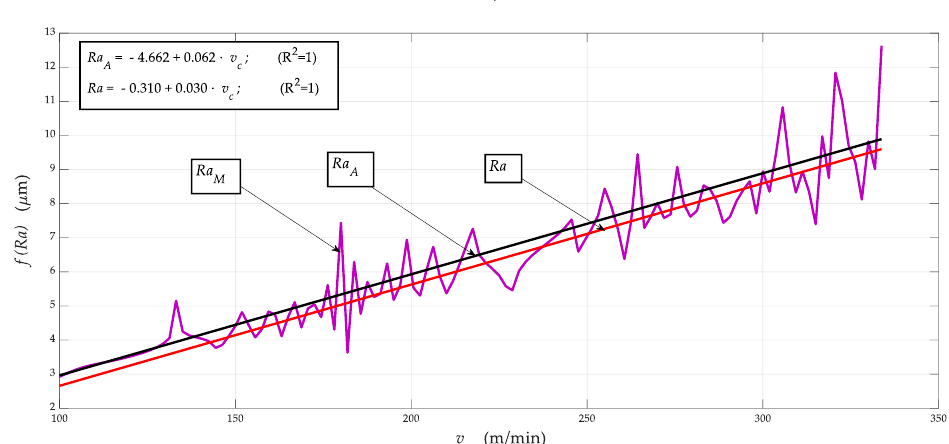
Figure 7. Dependences ( v co , a po , f o ) = f ( E mat ) for Stellite.